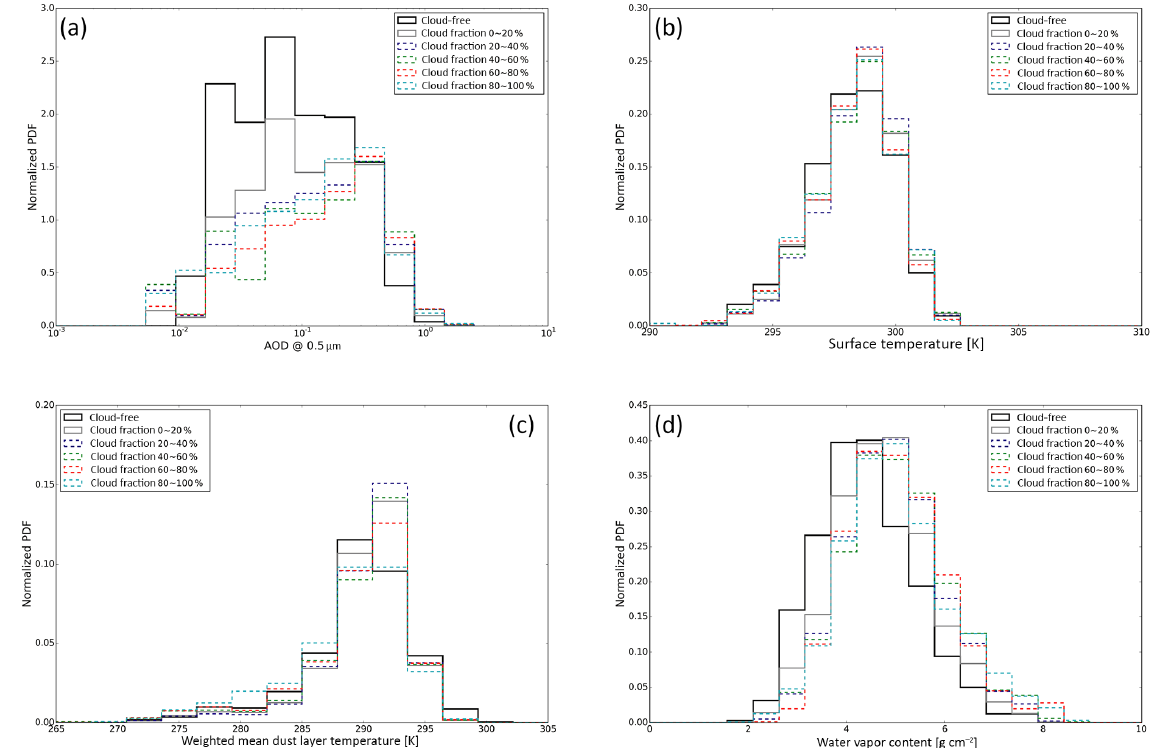
Figure 11. Histograms of (a) dust AOD, (b) surface temperature, (c) dust temperature, and (d) total column water vapor of dust-dominant CERES pixels with different cloud